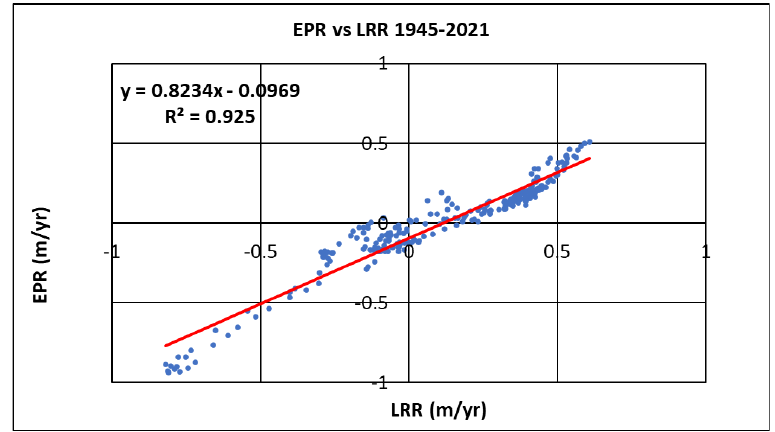
Figure 14. Correlation of EPR and LRR change rates for all transects.